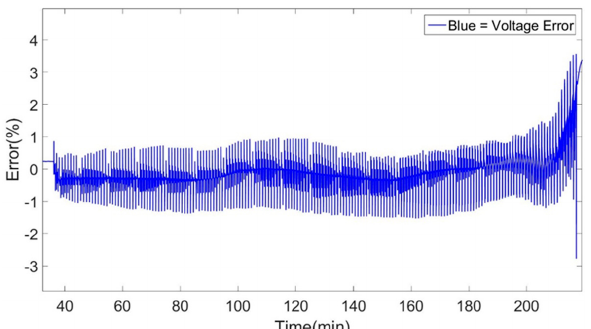
Figure 16. 2nd order Thévenin model measured and simulated DDP comparison at 25 °C with Coulomb counting and advanced characterization.